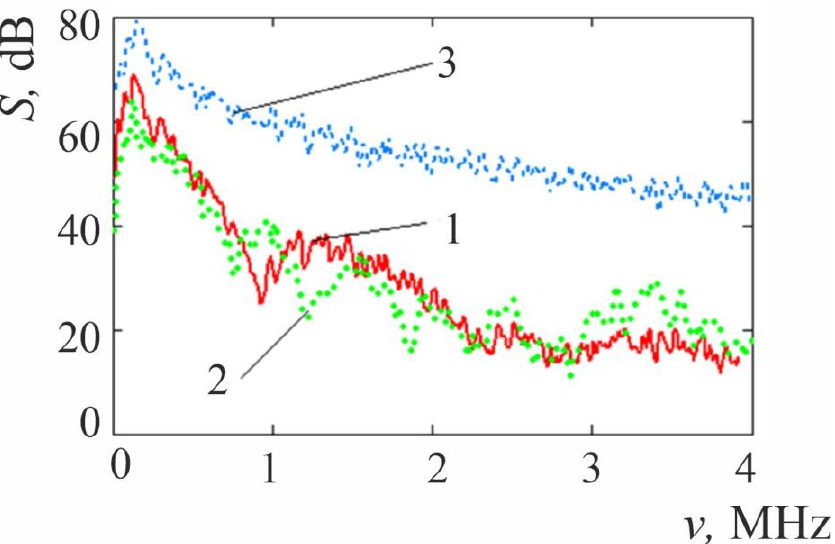
Figure 10. Spectra S ( ν ): 1—calculated US spectrum in the approximation of 20% of periodically arranged spheres, 80% arranged chaotically, 2 and 3—experimental US spectrum and the spectrum of the exciting laser pulse [9]. The diameter of the spheres is 1 μm.